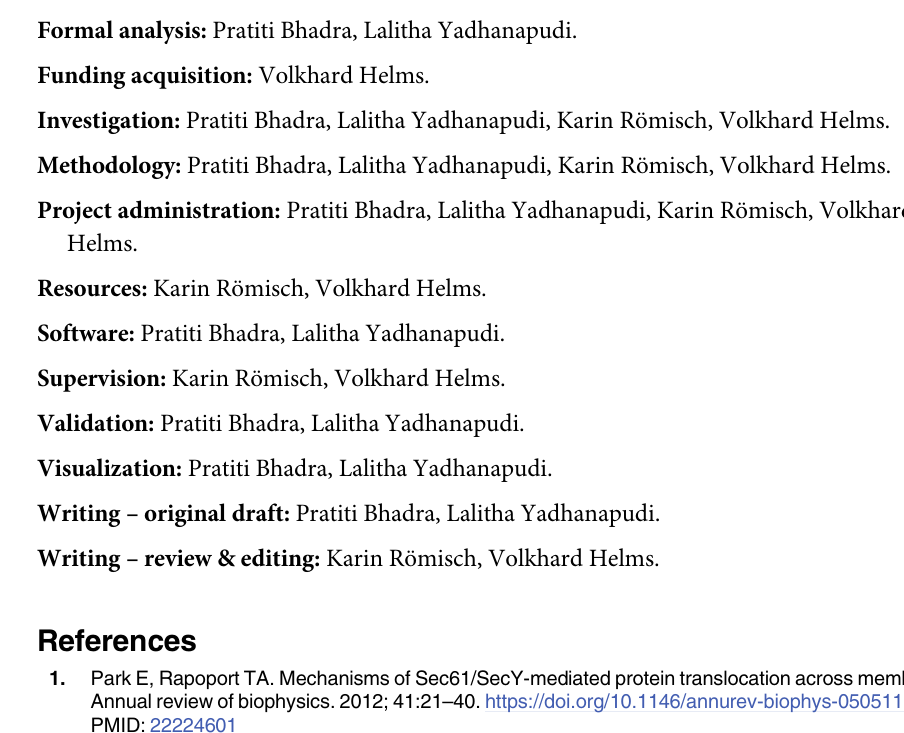
S23 Fig. Radius profile of Sec61 in PDB ID 6ND1 obtained from the MOLEOnline webser- ver [70]. S24 Fig. Left-panel: All final docking poses of the CPY-variant (LLTLLLCLLLL) [15] are rep- resented by line model. The final docking poses that satisfy the distance criterion are shown with thicker lines. Sec61, the TM2 helix and the TM7 helix are shown in surface model and cartoon model, respectively. The blue parts of TM2 and TM7 helices represent the C-terminus of TM2 and the N-terminus of TM7. Right-panel: The percentage of the total final docking poses where at least one residue of the hydrophobic core is located near ( � 0.3 nm residue-res- idue distance) the C-terminus of TM2 and the N-terminus of TM7. S1 Table. List of signal sequences used in this